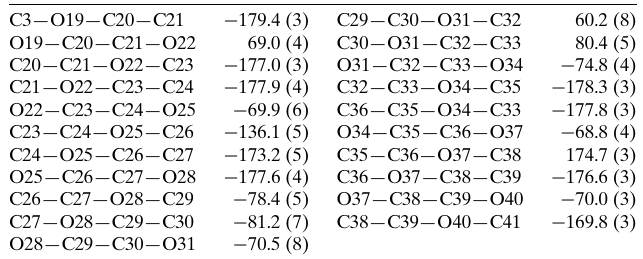
Table 1 Selected torsion angles ( (cid:4) ).